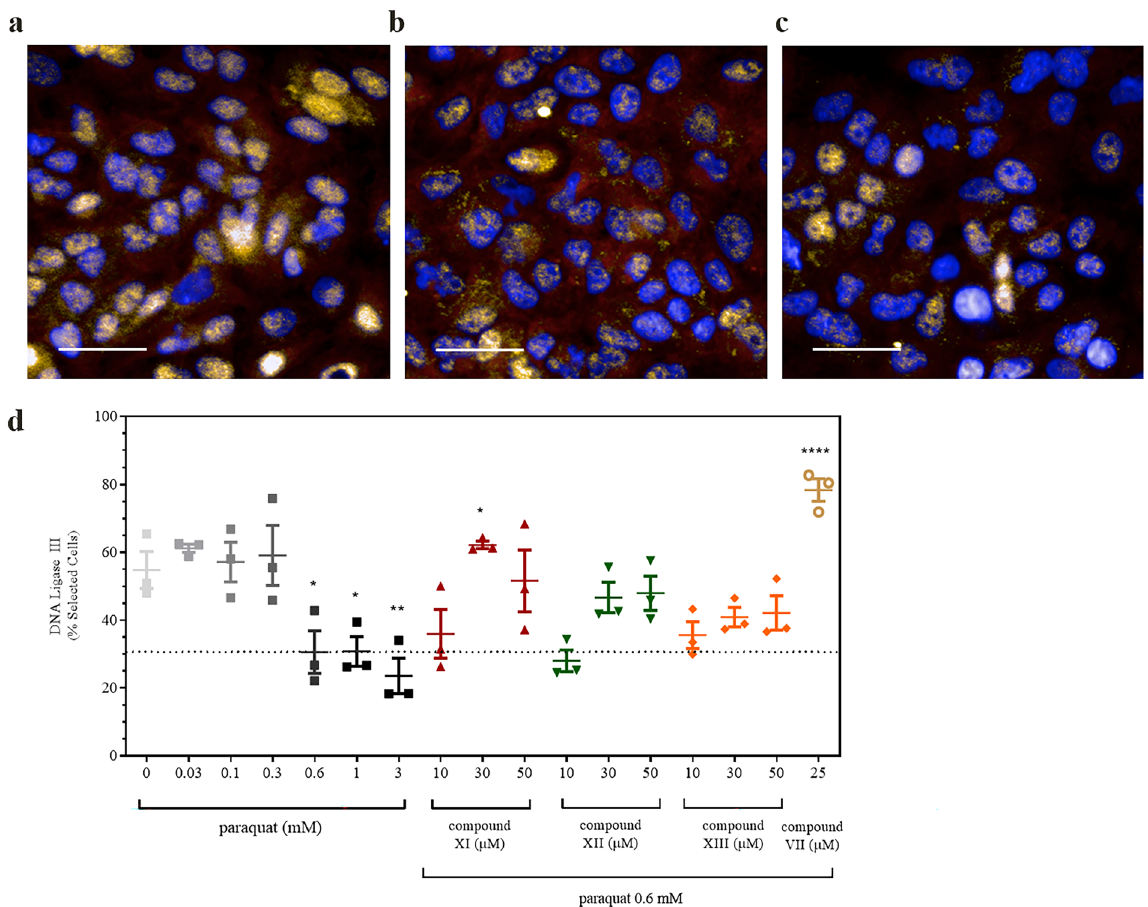
Figure 8. Effects of paraquat on DNA Ligase III in the presence and absence of OGG1 activators. Panels ( a – c ) represent images obtained in the absence and presence of 0.6 and 1.0 mM paraquat for 48 h, respectively. Sample images depict changes in DNA ligase III content (overlaid orange) with overlaid Cell Mask™ Deep Red (red) and Hoechst 33342 (blue). The line = 40 microns. In ( d ), graphical representation of the changes resulting in DNA ligase III content after exposure to 0.6 mM paraquat with the dotted line used to depict the changes brought about by the presence of the OGG1 activators (4 h pre-treatment). Similar data were obtained with 24 h of paraquat treatment (data not shown). Values are representative of two independent experiments performed in triplicate. In ( d ) p -values denoted by the asterisks from left to right of the panel equal 0.0427, 0.0448, 0.0083, 0.0239 and < 0.0001,